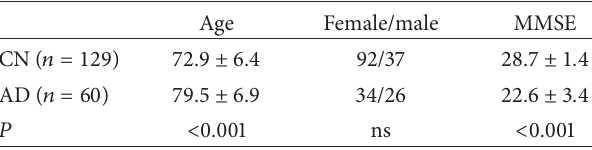
Table 1: Demographic and neuropsychological characteristics of